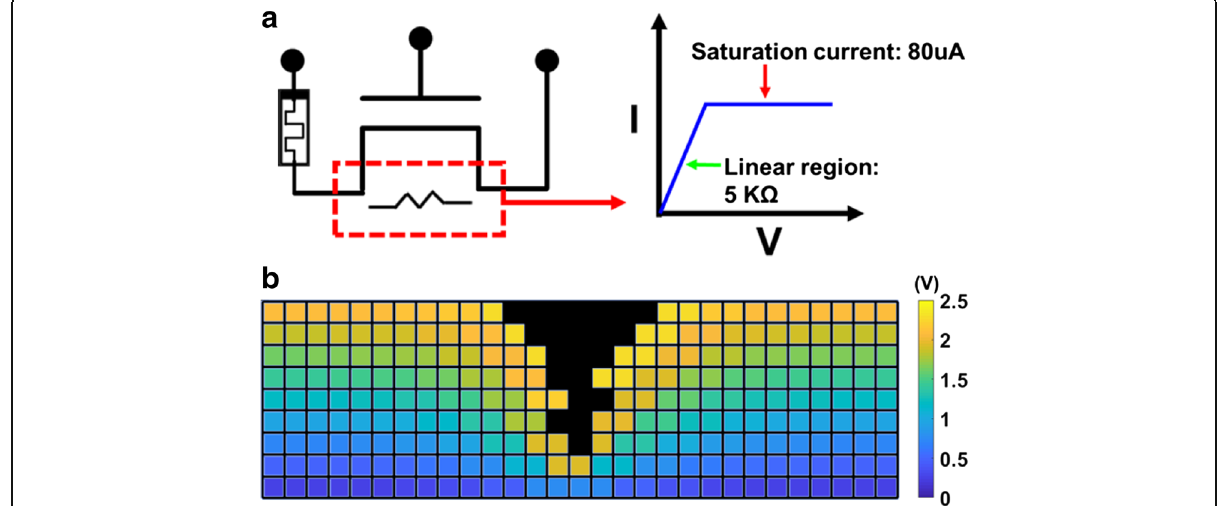
Fig. 8 a Forming operation is simulated by a CRRAM serially connected with an ideal transistor. b Non-uniform electric potential distribution, resulting from pre-existing Vo-, induces localized field and accelerates the generation of new defects